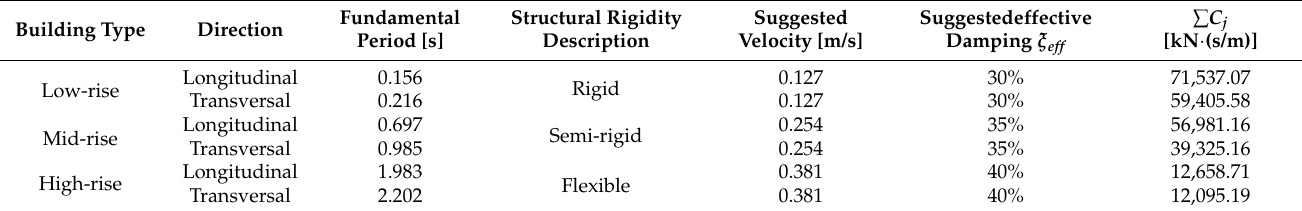
Table 8. Effective damping and calculated damping coefficient for the three investigated buildings ( α =